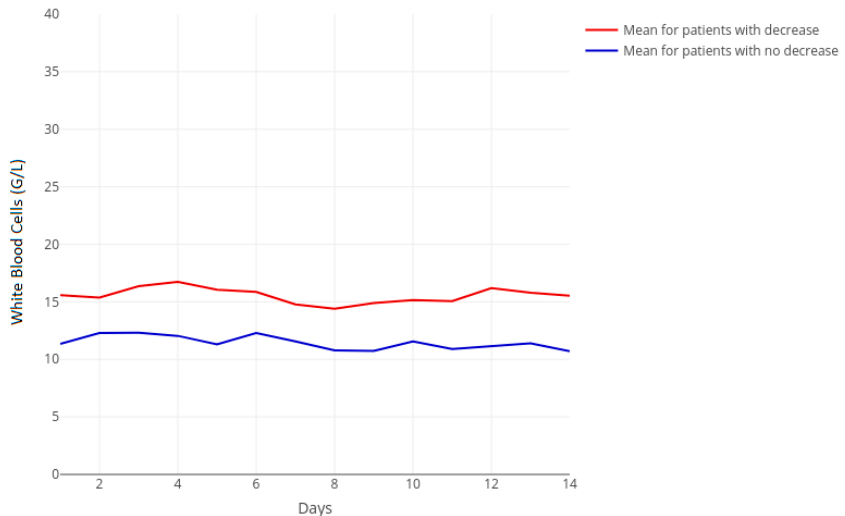
Figure 3. Temporal course of white blood cell (WBC) count separated for decreasing (red, n = 59) and non-decreasing (blue, n = 71) groups with corresponding groupwise means. WBC reflects white blood cell count. The horizontal axis represents days of treatment beginning at zero as the timepoint seven days before treatment. Day n represents the n th day of treatment.